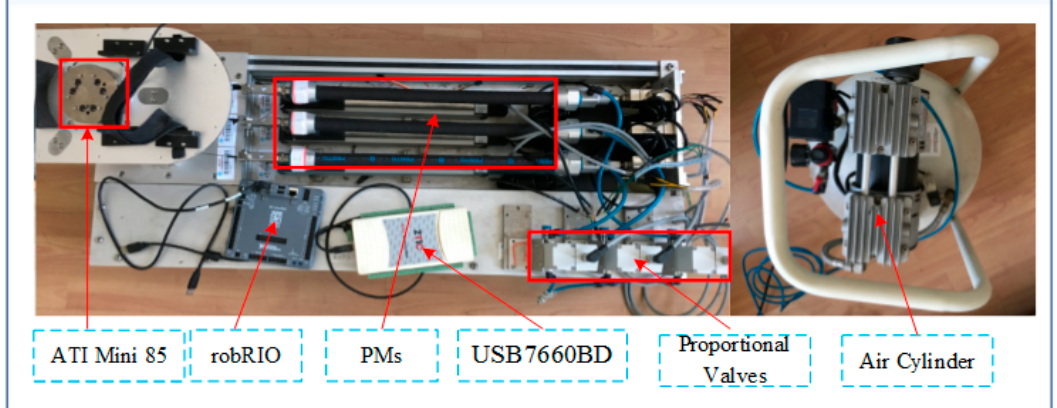
Figure 2. The developed ankle rehabilitation robot driven by PMs.